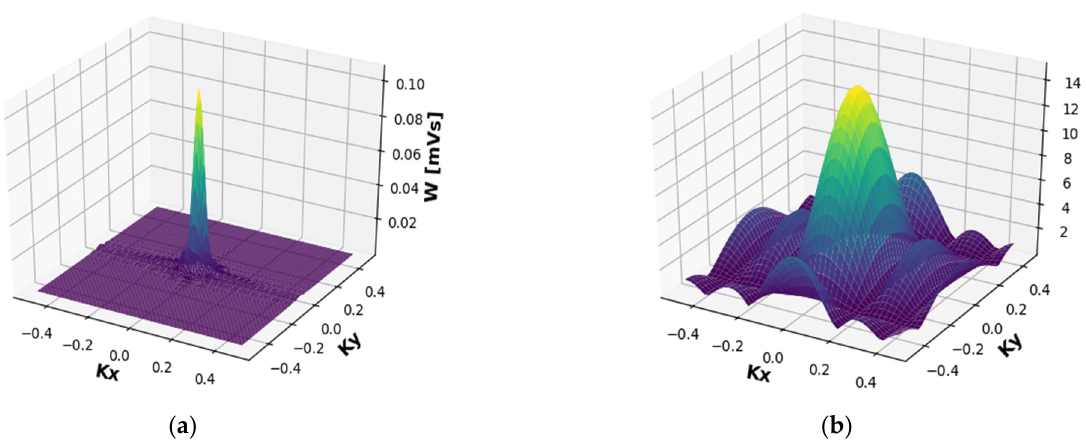
Figure 6. WDF from the center of the aperture— W x ( x = 0, y = 0). ( a ) Of the radiation field at 2.89 (THz). ( b ) Of the window function. The energy is concentrated in the middle of the aperture.